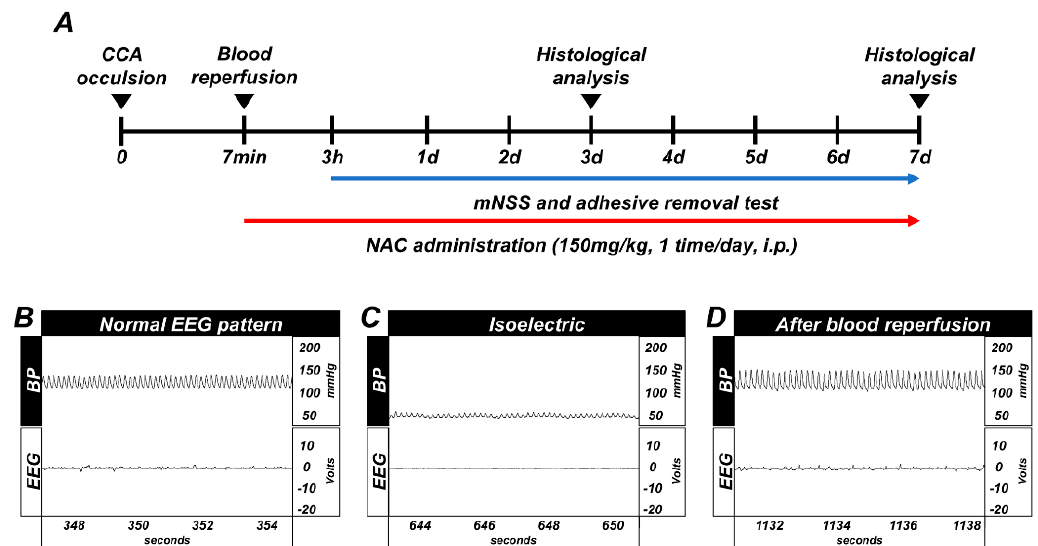
Figure 1. ( A ) Timeline representing the experimental design for 3 and 7 days following global cerebral ischemia (GCI). Experimental animals were given vehicle and N ‐ acetyl ‐ L ‐ cysteine (NAC) (dosage: 150 mg/kg) once per day for 3 and 7 days. During the 7 days of the experiment, animals were subjected to behavioral outcome assessment by adhesive removal test and modified neurological severity score measurement. Global cerebral ischemia (GCI) induces electroencephalograph (EEG) and blood pressure changes, and timeline of experiment. ( B ) Normal blood pressure, resting EEG pattern. ( C ) Blood pressure decreased up to 40 (diastolic)–50 (systolic) mmHg, and EEG displayed isoelectric pattern. ( D ) Blood pressure and EEG pattern completely normalized after blood reperfusion.